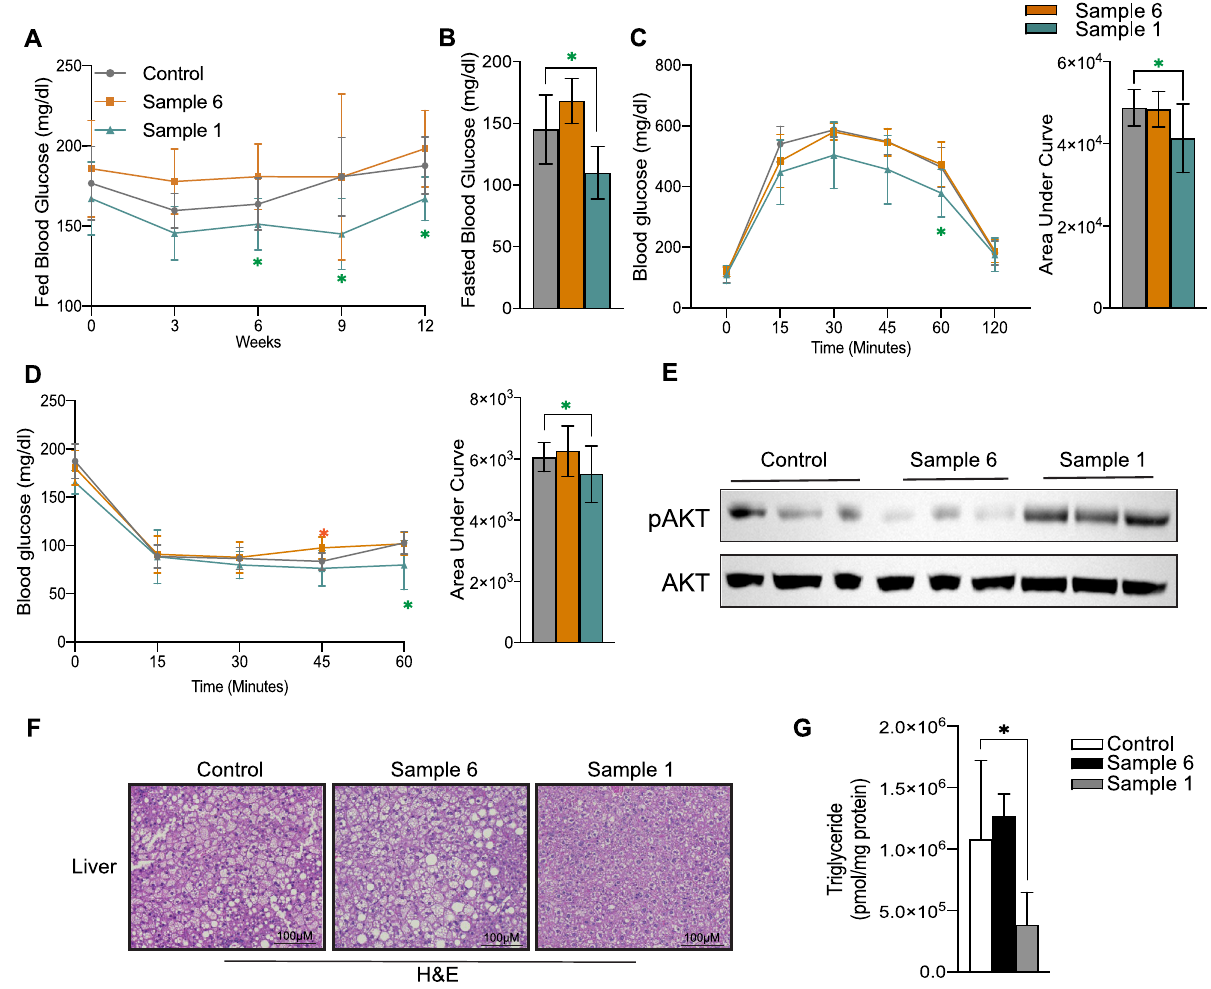
Figure 5. Cordyceps enriched in myriocin increases insulin sensitivity, resolves hepatic steatosis. C57Bl6/J mice fed high fat diets supplemented with starch (control), Sample 1 and Sample 6 for 12-weeks. ( A ) Fed blood glucose levels were determined every 3-weeks until the end of the study. ( B ) Fasted blood glucose levels were determined following 10-weeks of dietary intervention. ( C ) Glucose and ( D ) Insulin tolerance tests were performed following 4-weeks of dietary intervention (N = 5–7 animals per group). Following euthanasia, ( E ) liver pAKT (s473) and AKT was determined by Western Blotting (N = 3 animals per group), ( F ) livers were evaluated histologically (H&E staining; N = 3–4 animals per group) and ( G ) liver triglyceride content was determined by mass-spectrometry (N = 5 animals per group). Values are expressed as mean ± SEM, *p < 0.05, **p < 0.001, ***p < 0.0001 vs